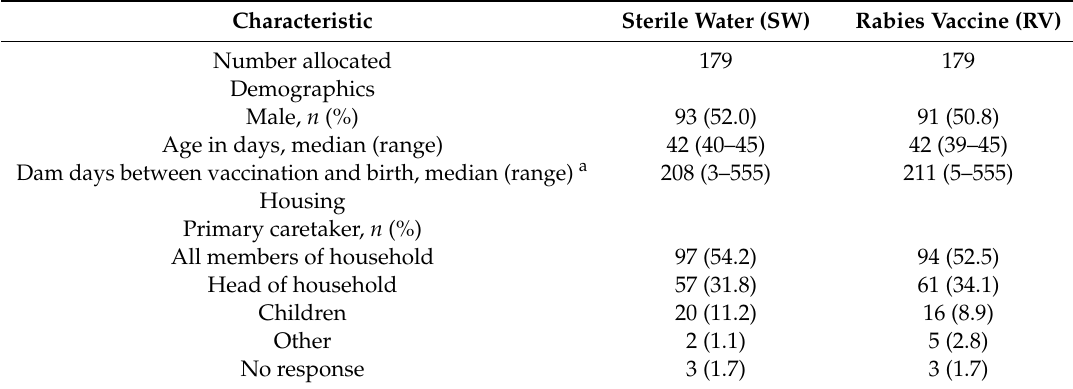
Figure 1. Flowchart of study subjects. SW = sterile water (control); RV = rabies vaccine. Table 1. Characteristics of subjects at baseline (6 weeks of age).